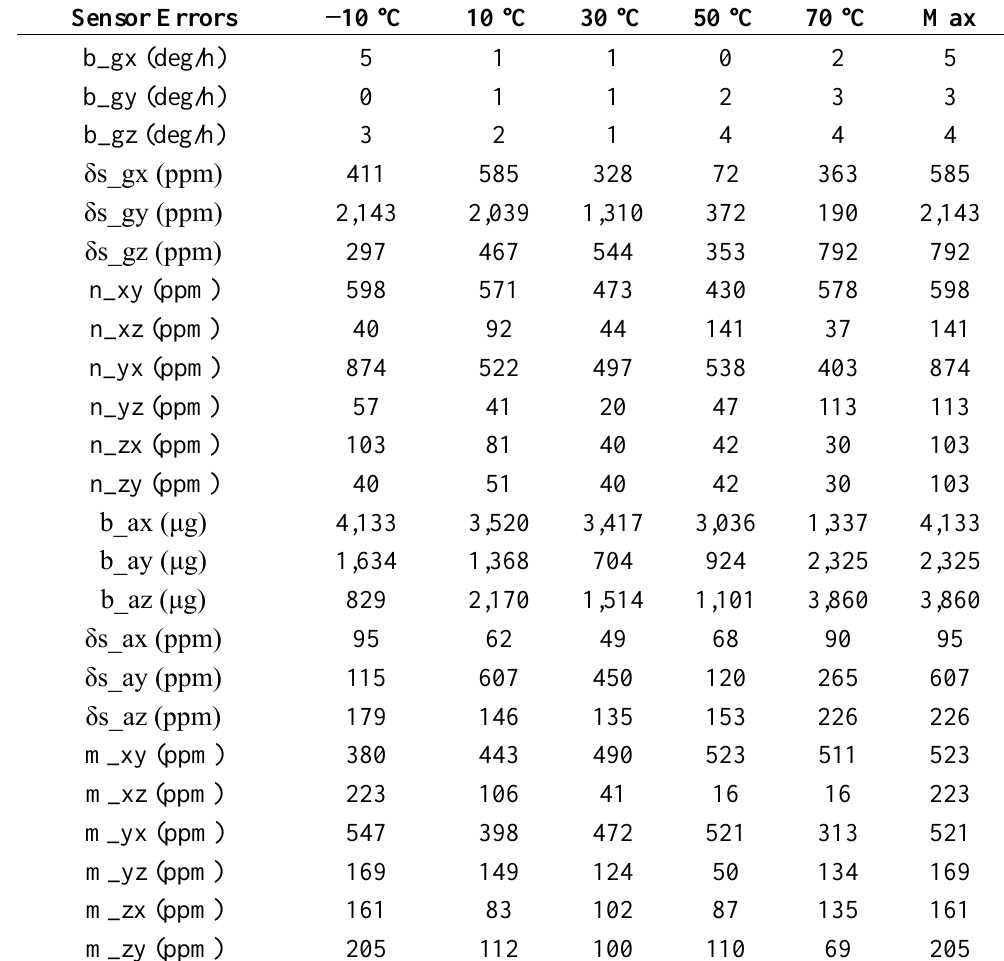
Table 6. Errors (RMS) of NV-IMU100 thermal calibration at typical temperature points (using the results of the Soak method as reference).